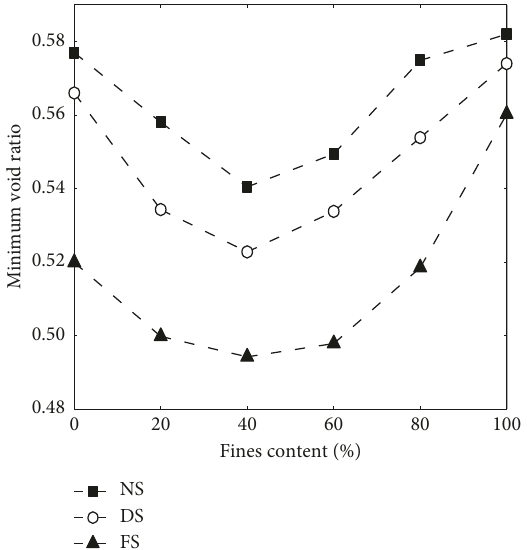
Figure 6: Mixing two groups (1-2 mm and 0.5–1mm).